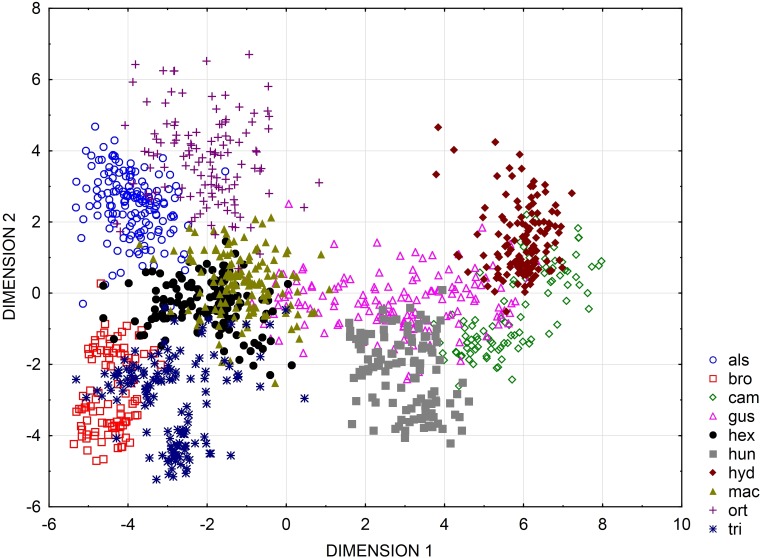
Categorized scatterplot based on canonical analysis value for seeds of the European species of Elatine.For acronyms, see Table 1.